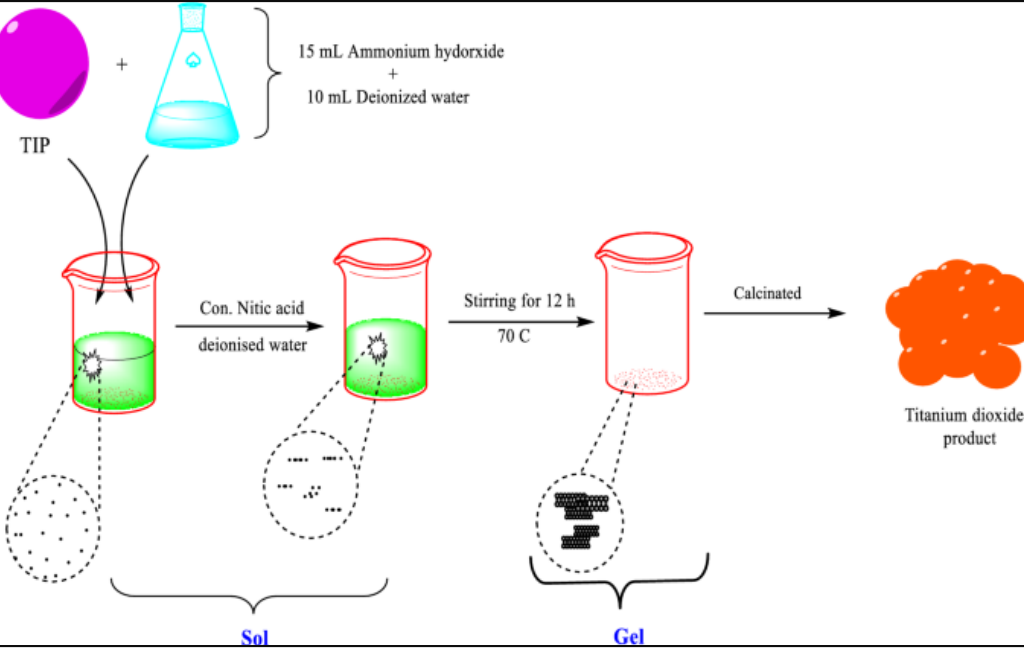
Figure 5. Preparation of TiO 2 nanoparticles by sol-gel method [131], with permission from Springer Nature, 2022.